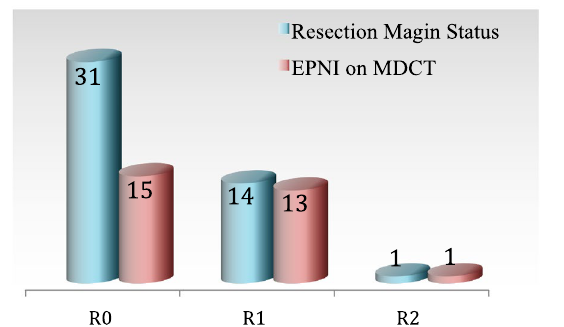
Figure 5. Comparison of CT findings of extrapancreatic perineural invasion with